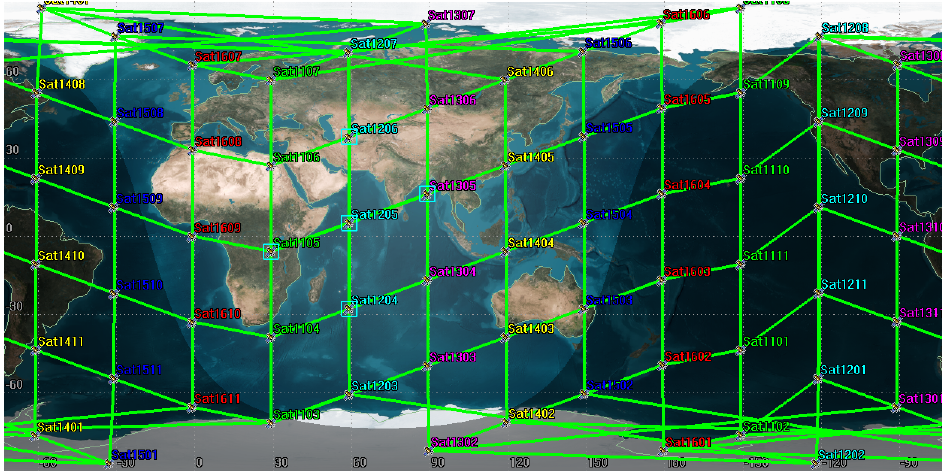
Figure 5. Three-dimensional plan of the satellite Internet of Things. ( a ) Observation point of Sat1205; ( b ) Observation point of Sat1404.